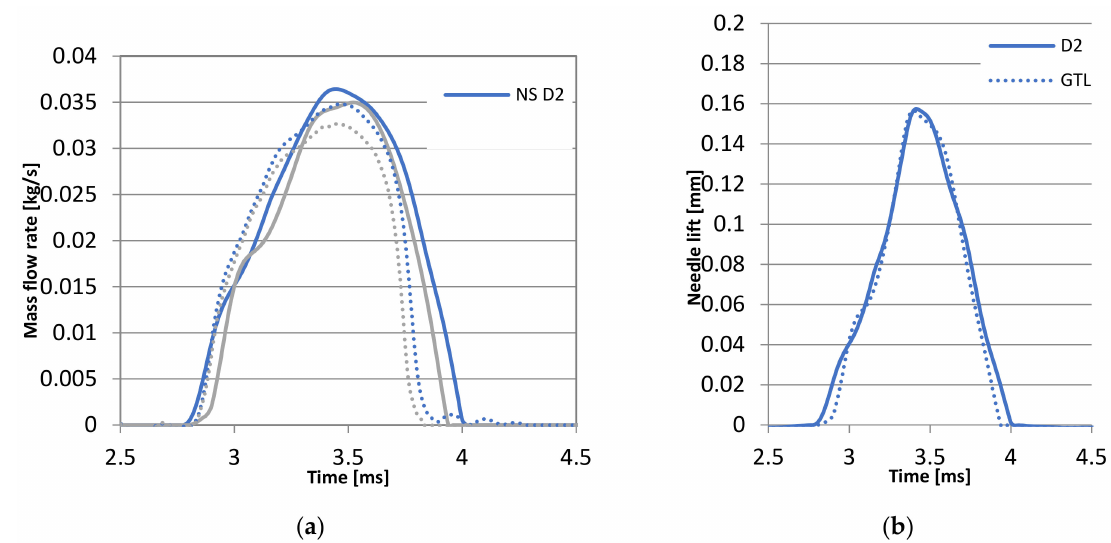
Figure 5. Influence on injection process: ( a ) Experimentally and numerically obtained fuels mass flows for a whole injector: Evolution of mass flow rate over time; ( b ) Numerically obtained needle lift for D2 and GTL